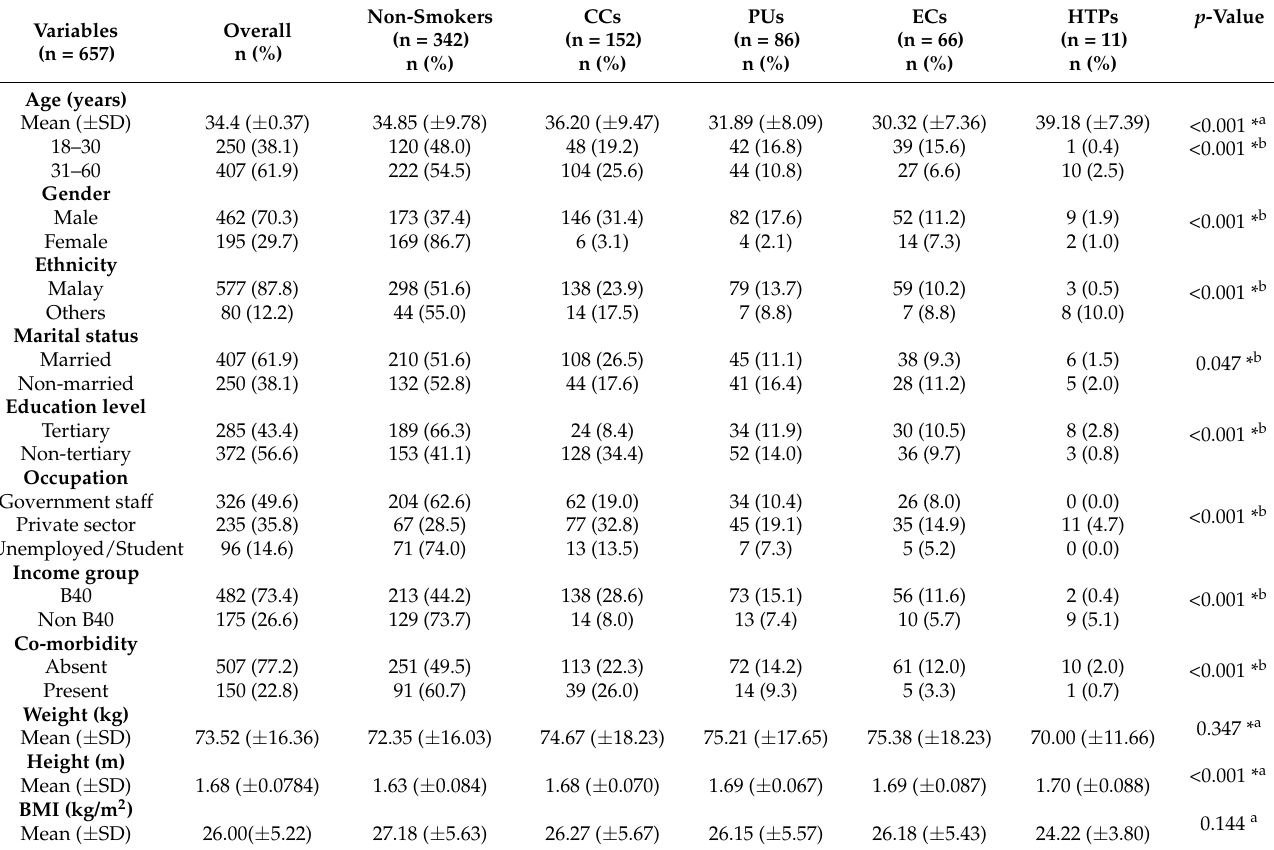
Table 1. Demographics of study population according to smoking status (n =